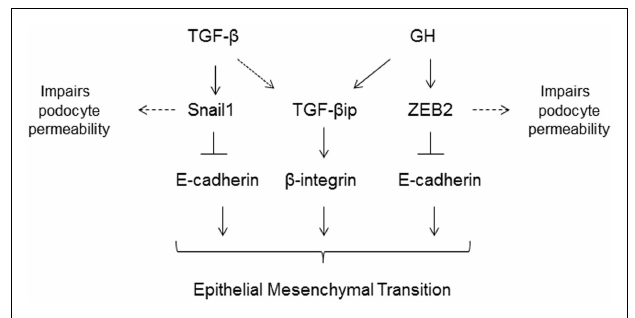
FIGURE 3 |TGF- β and growth hormone (GH) induce epithelial-to-mesenchymal (EMT) transition of podocytes via activation of Snail1 and ZEB2 genes, respectively . BothTGF- β and GH induce expression ofTGF- β induced protein (TGF- β ip). In addition to inducing EMT, these transcriptional factors also suppress expression of slit-diaphragm proteins resulting in increased podocyte permeability to plasma